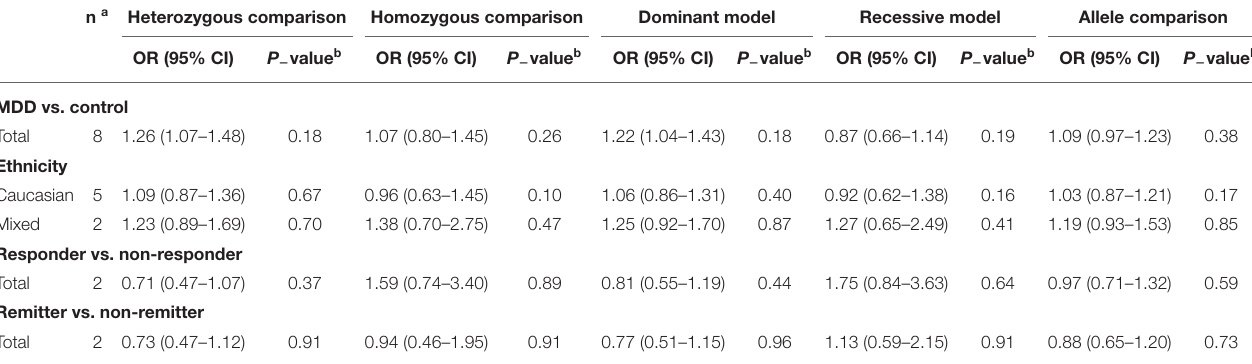
TABLE 2 | Meta-analysis of HTR1B rs6296 polymorphism and the risk of MDD and ADR. n a Heterozygous comparison Homozygous comparison Dominant